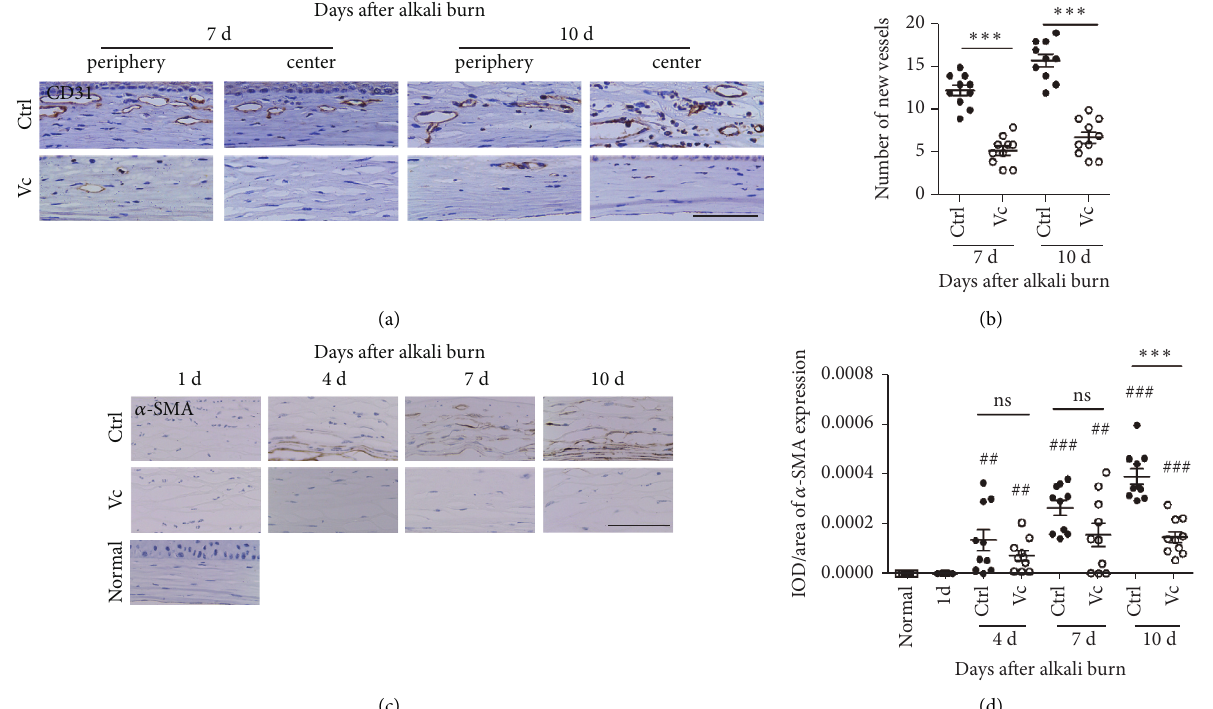
Figure 5: Quantification of neovascularization and the opacity of alkali-burned mouse corneas. (a) Representative CD31 staining images in the alkali-burned corneas on days 7 and 10 after injury. (b) The number of CD31-positive new vessels in the two groups. (c) The expression of the smooth muscle actin (SMA) of the two groups from day 1 to day 10 after immunohistochemical staining. (d) The IOD/areas of α -SMA in the corneal stromas of the two groups. IOD means integral optical density. Abbreviations: Ctrl, control group (sterile water group); Vc, vitamin C group; ns, no significant difference between the indicated groups. ∗ Means the comparison of Vc group and control group. # Means the comparison with day 1. ∗∗ p < 0 . 01, # p < 0 . 05, and ## p < 0 . 01. Scale bar � 50 μ